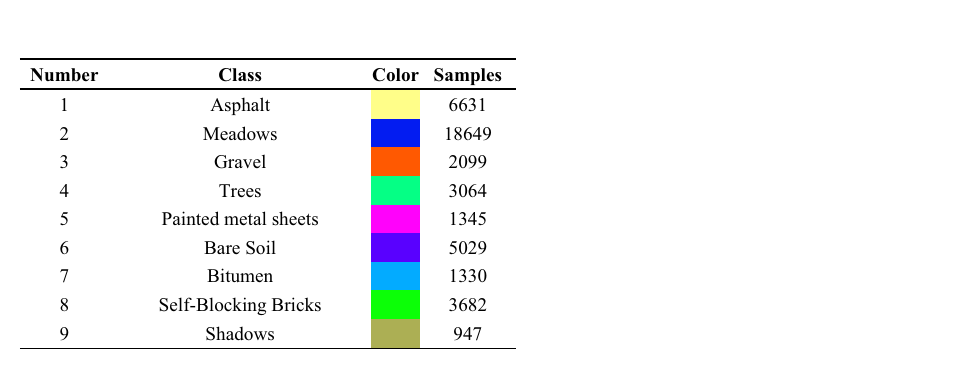
(b) True classification map of the ground(a) False color image synthesized by bands 29, 42 and 89 Figure 3. The image and ground truth classification map of Pavia university area.